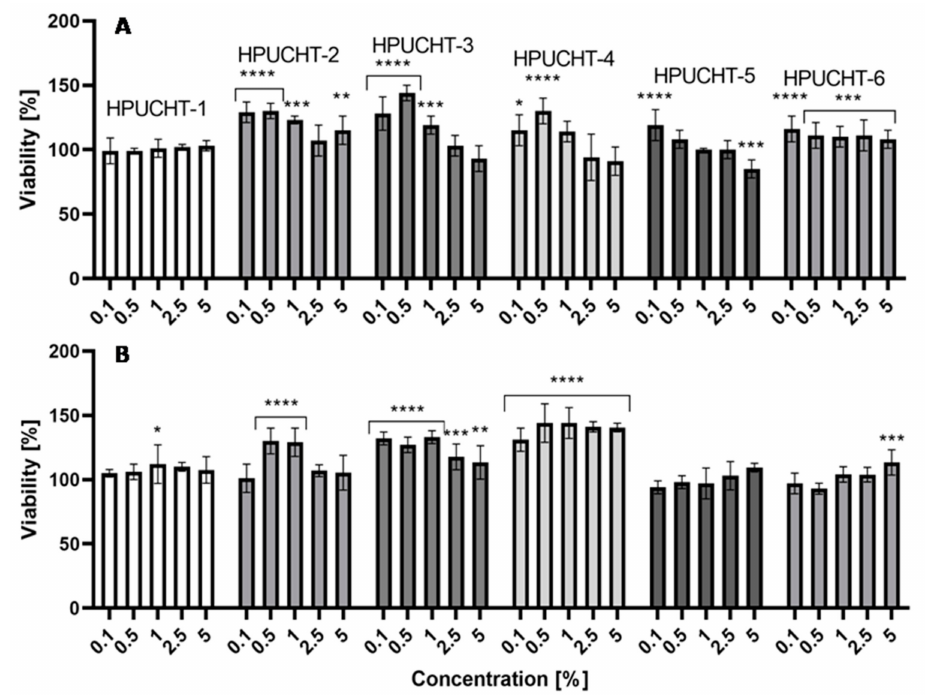
Figure 4. Effectof different concentrations of extracts (0.1–5%) from hydrogels on NR uptake in cultured HaCaT cells after 2 h ( A ) and 24 h ( B ) of exposure. **** p ≤ 0.0001, *** p ≤ 0.001, ** p ≤ 0.01, * p ≤ 0.05 versus the control (100%).